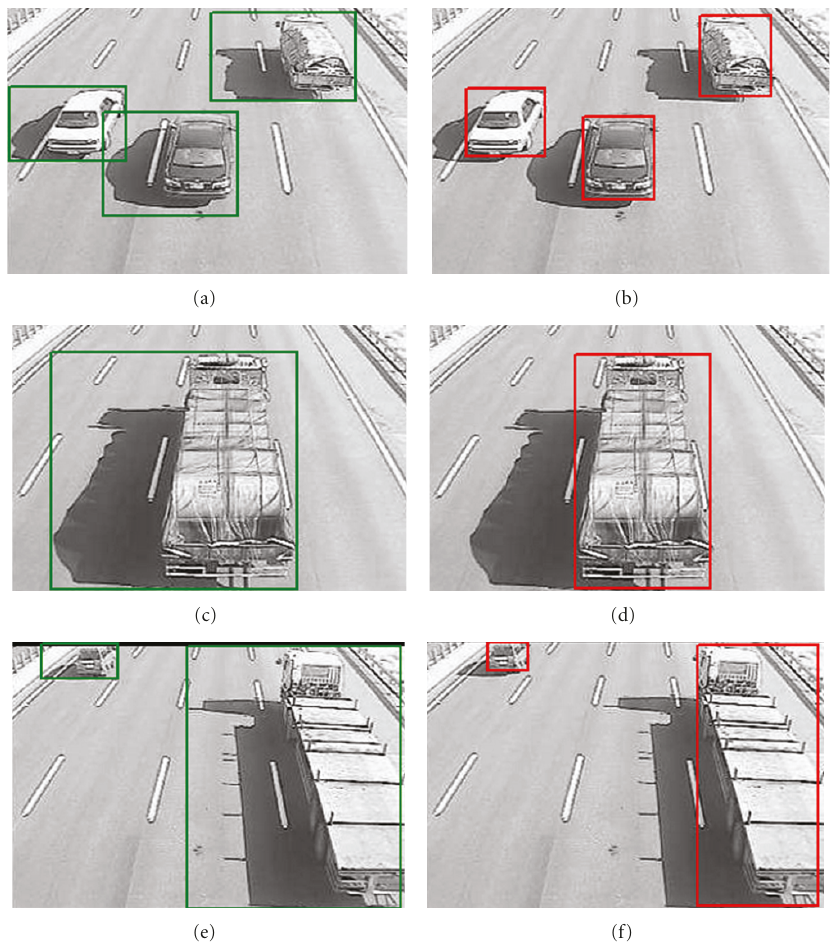
Figure 26: Experimental results of foreground object detection.